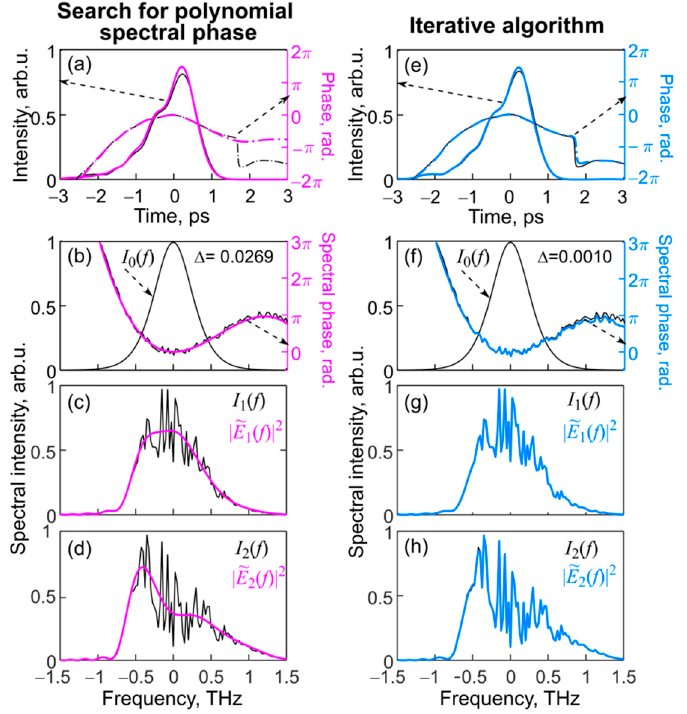
Figure 5. Reconstruction of the pulse with random addition to the spectral phase. (( a – d ), left column) Solution for polynomial spectral phase found for the global minimum of error function Δ ( C 2 = 6.3 ps 2 and C 3 = − 3.5 ps 3 ). (( e – h ), right column) Solution found for the global minimum using the iterative algorithm. ( a , e ) Intensity and phase in the time domain; ( b , f ) input pulse spectrum and spectral phase; ( c , g ); converted spectra at the output for B 1 = 1; ( d , h ) converted spectra at the output for B 2 = 2. Black curves calculated for the initial pulse and color (magenta and blue) curves correspond to numerically reconstructed pulses.